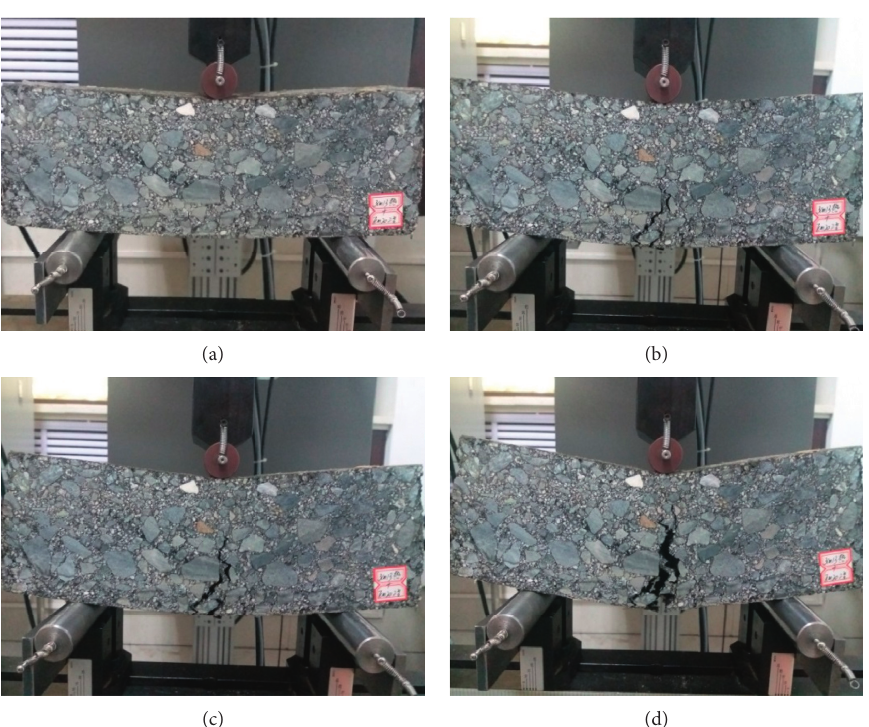
Figure 5: Double-layer beam fatigue test process. (a) Initial specimen. (b) Crack propagation. (c) Further crack propagation. (d) Final